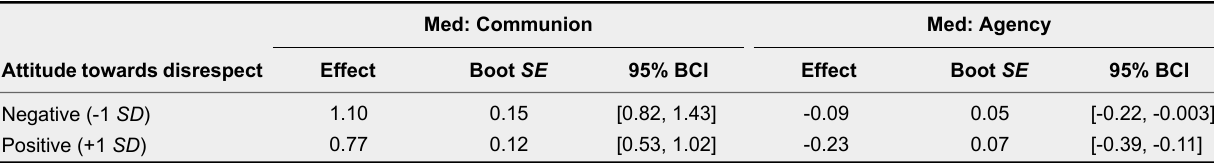
Conditional Indirect Effect of Disrespectful vs. Respectful Candidate Behavior a on Voting Intention Dependent on Voters’ Attitude Towards Disrespect in Politics in Study 1